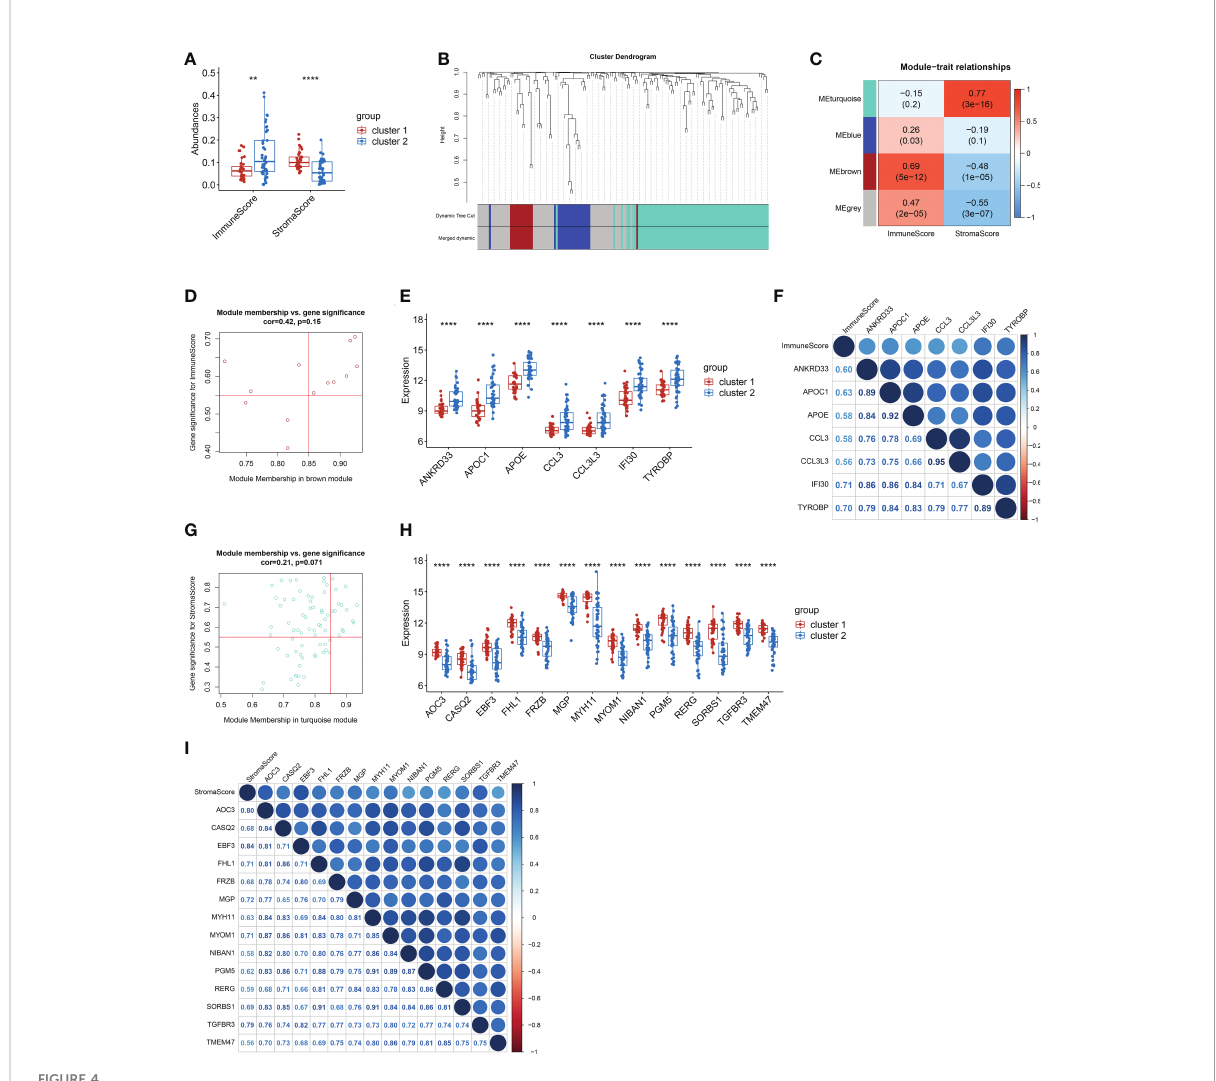
FIGURE 4 The screening of genes that related to Immune score and stroma score. (A) . The immune score and stroma score of cluster and cluster 2. (B) . Cluster dendrogram of the co-expression network modules. (C) . Correlations between the modules and immune scores, and correlations between the modules and immune scores (p-values were shown). (D) . Scatter plot analysis of the brown module. 7 Immune score-related genes were screened out in the upper-right area where GS > 0.55 and MM > 0.85. (E) . Comparison of the 7 immune score-related genes between cluster 1 and cluster 2. (F) . Correlation analysis between the 7 immune score-related genes. (G) . Scatter plot analysis of the turquoise module. 14 stroma score-related genes were screened out in the upper-right area where GS > 0.55 and MM > 0.85. (H) . Comparison of the 14 stroma score-related genes between cluster 1 and cluster 2. (I) . Correlation analysis between the 14 stroma score-related genes. (**p< 0.01; ****p< 0.0001; GS, gene signi fi cance. MM, module